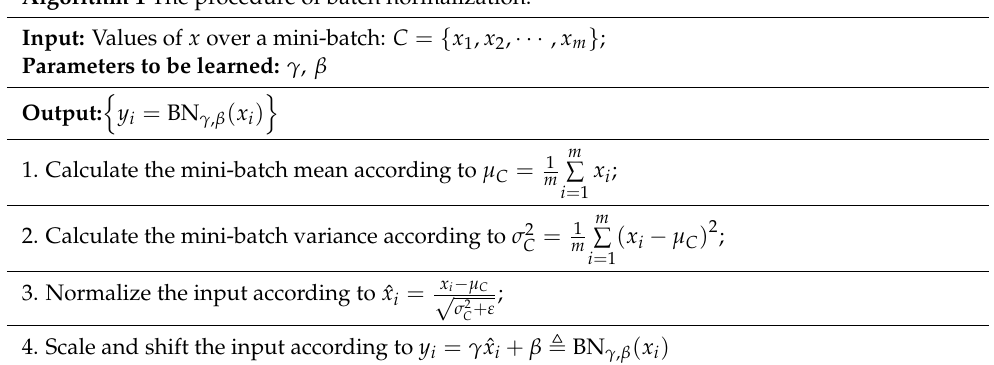
Algorithm 1 The procedure of batch normalization.